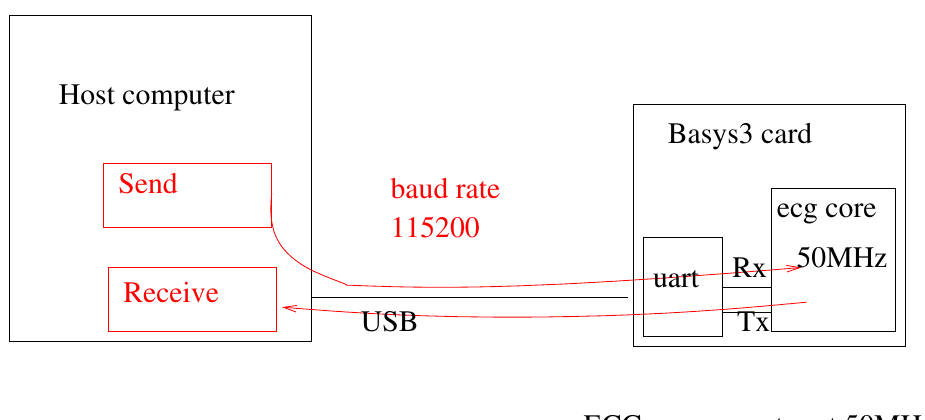
Figure 8. Test setup using the BASYS-3 FPGA card.